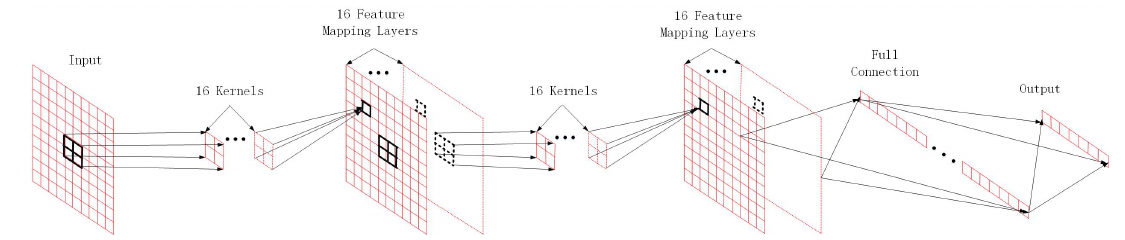
Figure 2. Proposed architecture diagram of